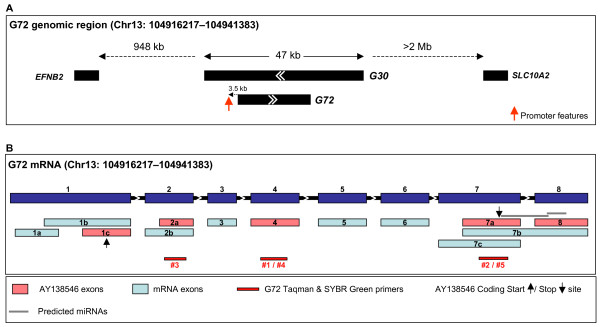
Genomic context and gene structure of the G72 gene on Chr. 13. (A) Representation of the genomic context around the G72 gene on chromosome 13, showing overlapping and neighbouring genes. The red arrow indicates the region where the in silico promoter tools predict features (see main text). (B) Gene structure of G72 showing exons of splice variant AY138546 in pink and exons of other variants in blue. G72 Taqman and SYBR Green primers are indicated in red, the AY138546 coding start and stop sites are shown as black arrows and predicted miRNA sequences in the AY138546 UTR are depicted in grey.